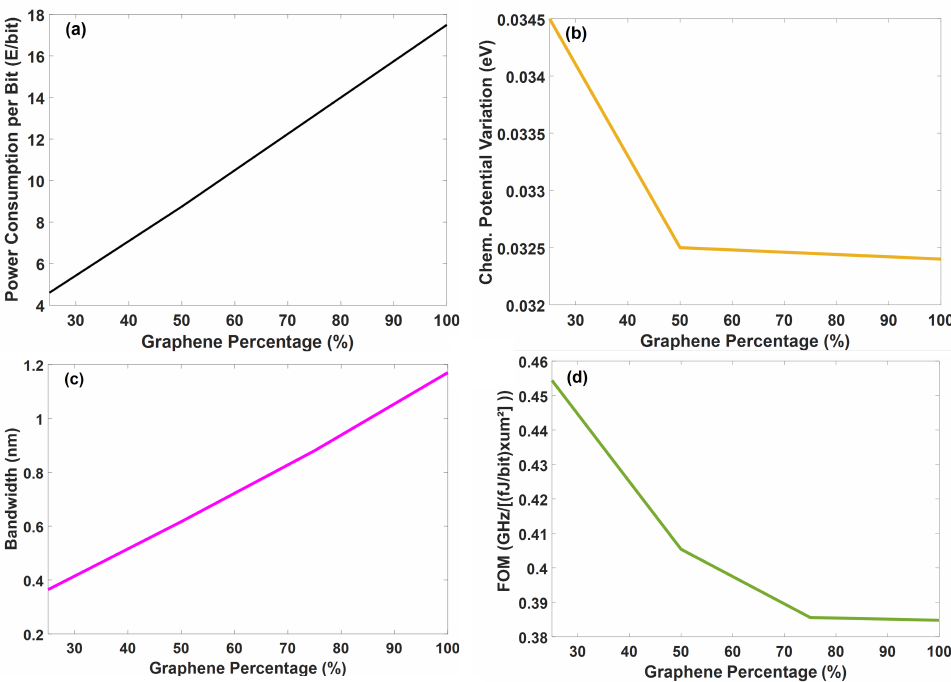
Figure 5. The performance of the modulator. ( a ) The power consumption per bit versus the graphene percentage. ( b ) The chemical potential variation versus the graphene percentage. ( c ) The − 3 dB- bandwidth versus the graphene percentage. ( d ) The trade-off performance